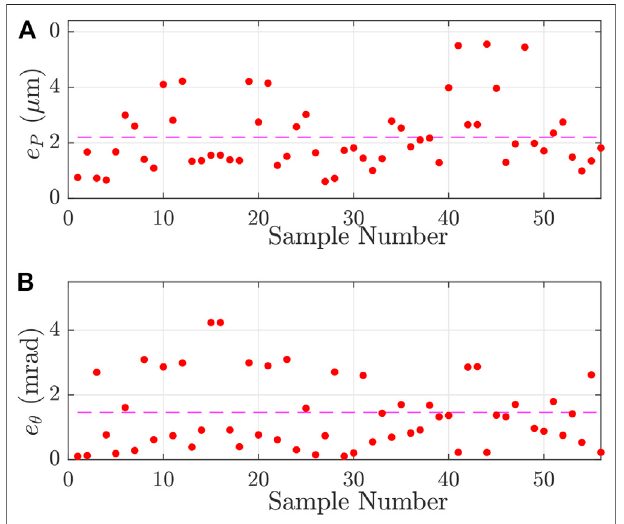
FIGURE 9 | Positioning (A) and orientation (B) errors of the model (respectively e P and e θ ) for the different samples the validation set of joints coordinates. The dashed-lines are the mean values of positioning and orientation accuracy and respectively correspond to 5.5 µm and 1.5